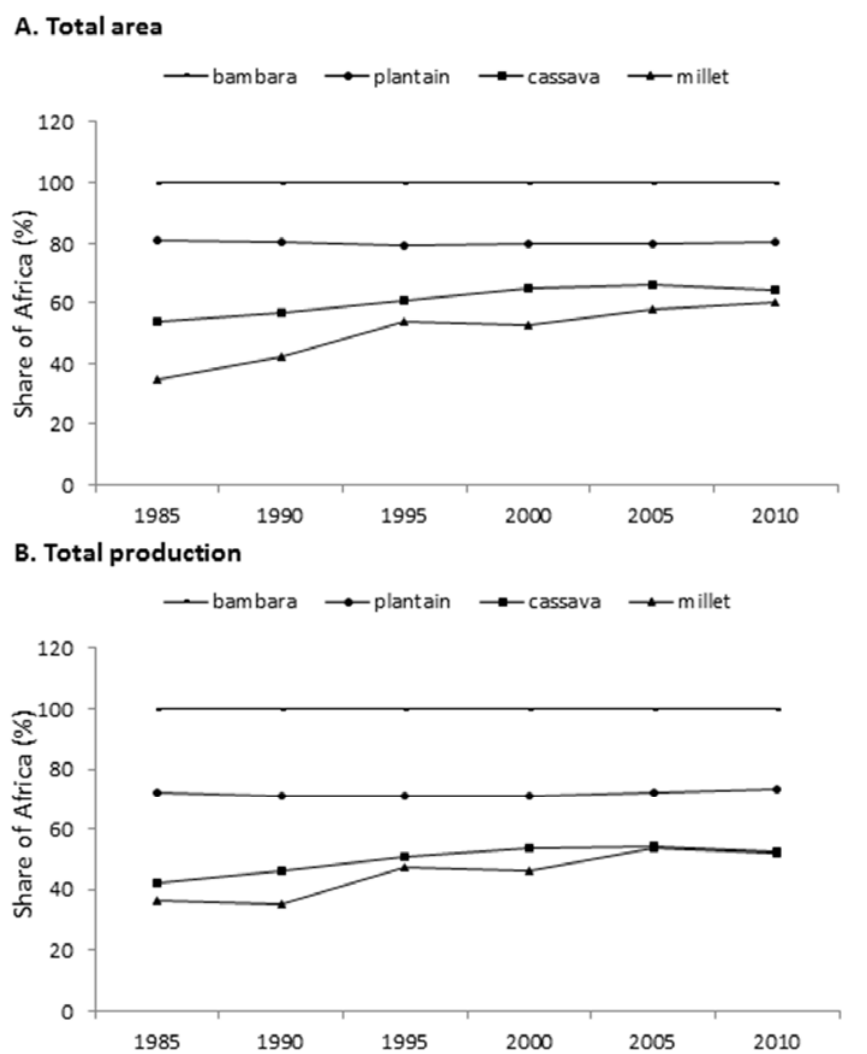
Figure 1. Share of Africa in the global crop area ( A ), and production ( B ) for selected orphan crops from 1985 to 2010. Adapted from FAOSTAT